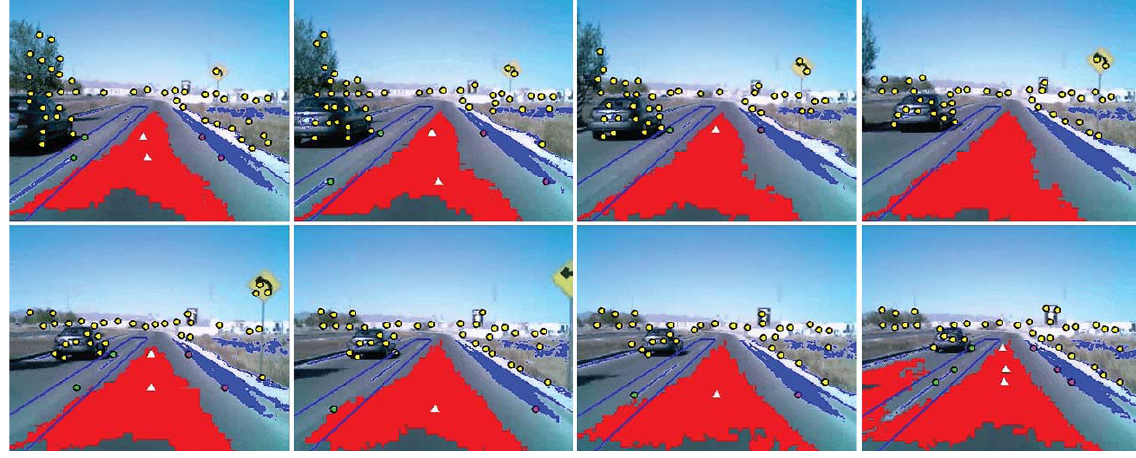
Fig. 3. Outdoor experiments using vision were realised to detect φ i corresponding to γ and α . The triangles define attraction areas for the weighting function w ( u , f γ t ) to impact f γ t ( (cid:3) δ